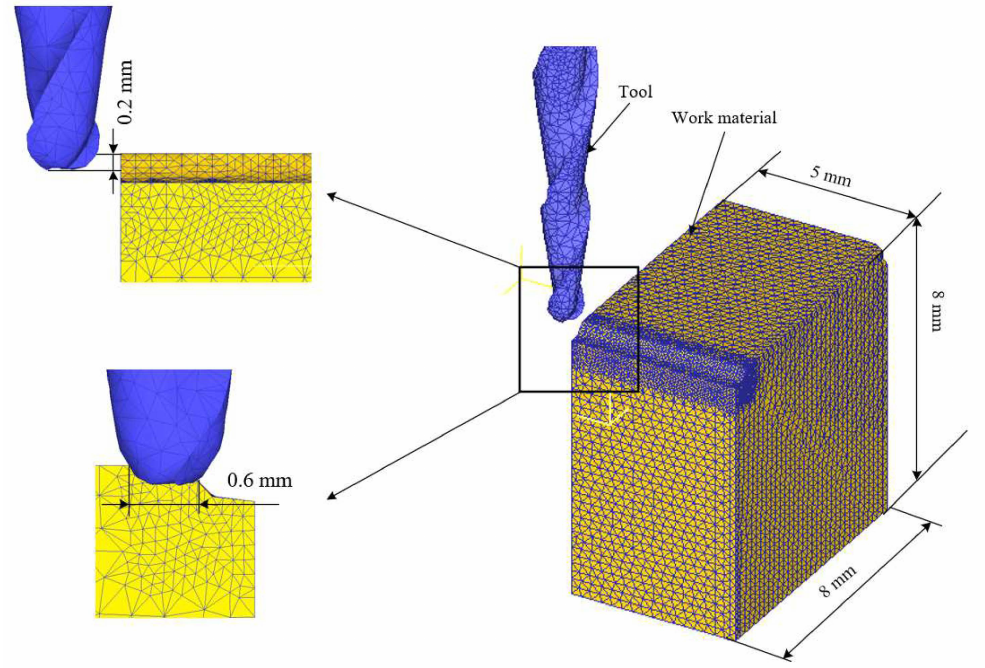
Figure 1. The three-dimensional FE cutting model used in machining simulations.